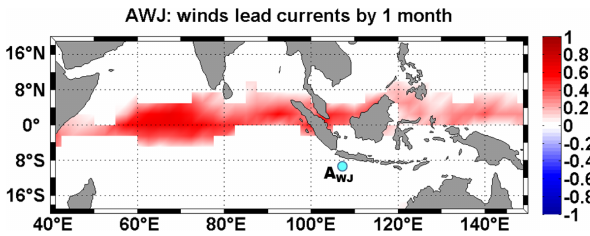
Figure 15. A correlation map between zonal wind and zonal cur- rents (at 30m) at A WJ for the semiannual signals extracted using the EEMD method. The 95% significance level is approximately ±